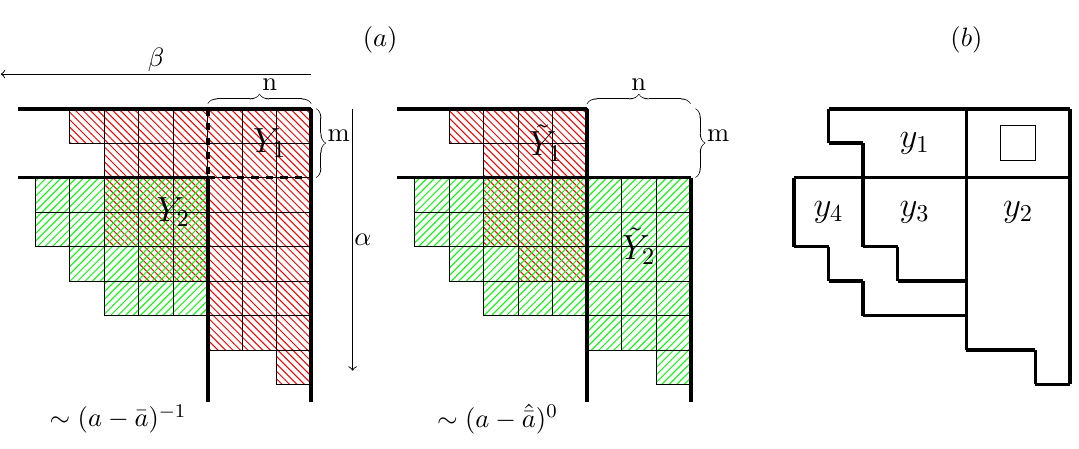
Figure 7 . (a) Example of a family of one member with the correspondent exponent of ( a − ¯ a ) and its dual family with the correspondent exponent of ( a − ˆ¯ a ) . There is an overlap, but no blinking group. (b) Overline of subregions of the